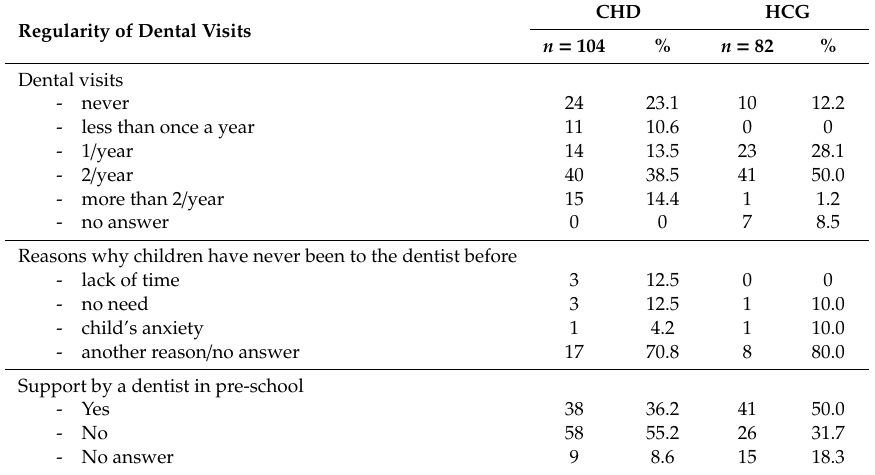
Table 4. Answers regarding the regularity of dental visits in the CHD group compared with